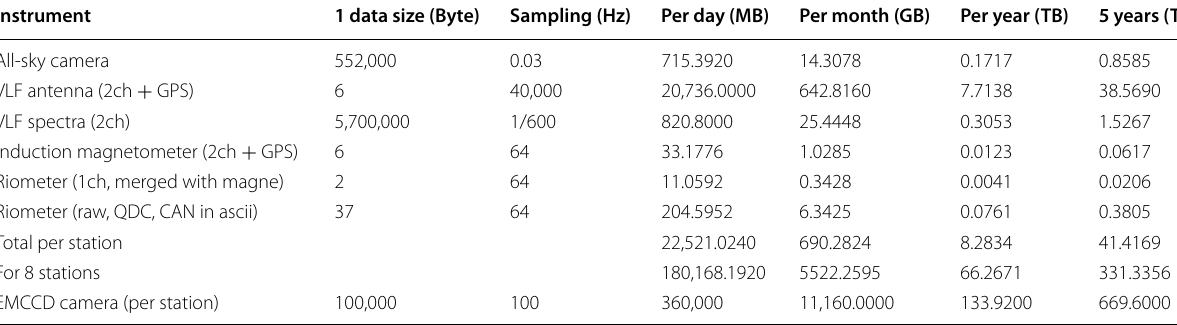
Table 3 Data amount from the PWING